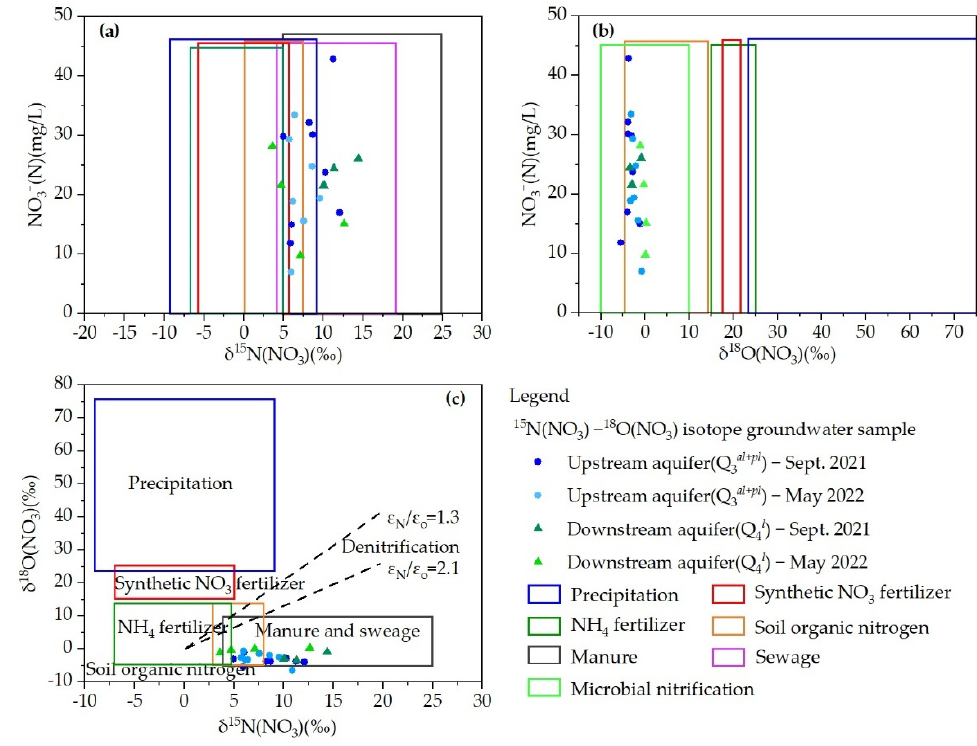
Figure 11. Relationships of NO 3 − vs. δ 15N (NO 3 ) ( a ), NO 3 − vs. δ 18 O(NO 3 ) ( b ) and δ 15N (NO 3 ) vs. δ 18 O(NO 3 ) ( c